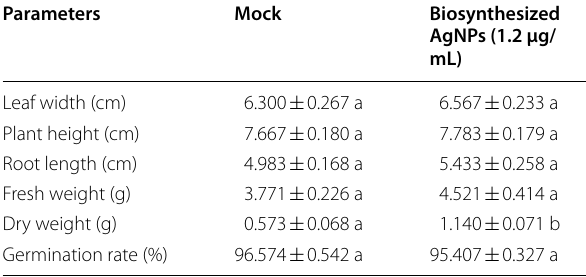
The data are the mean standard error ( n 3). Different lowercase letters ± = indicate significant difference in ANOVA univariate analysis (LSD test, P < 0.05). Mock indicates treatment with sterilized distilled water